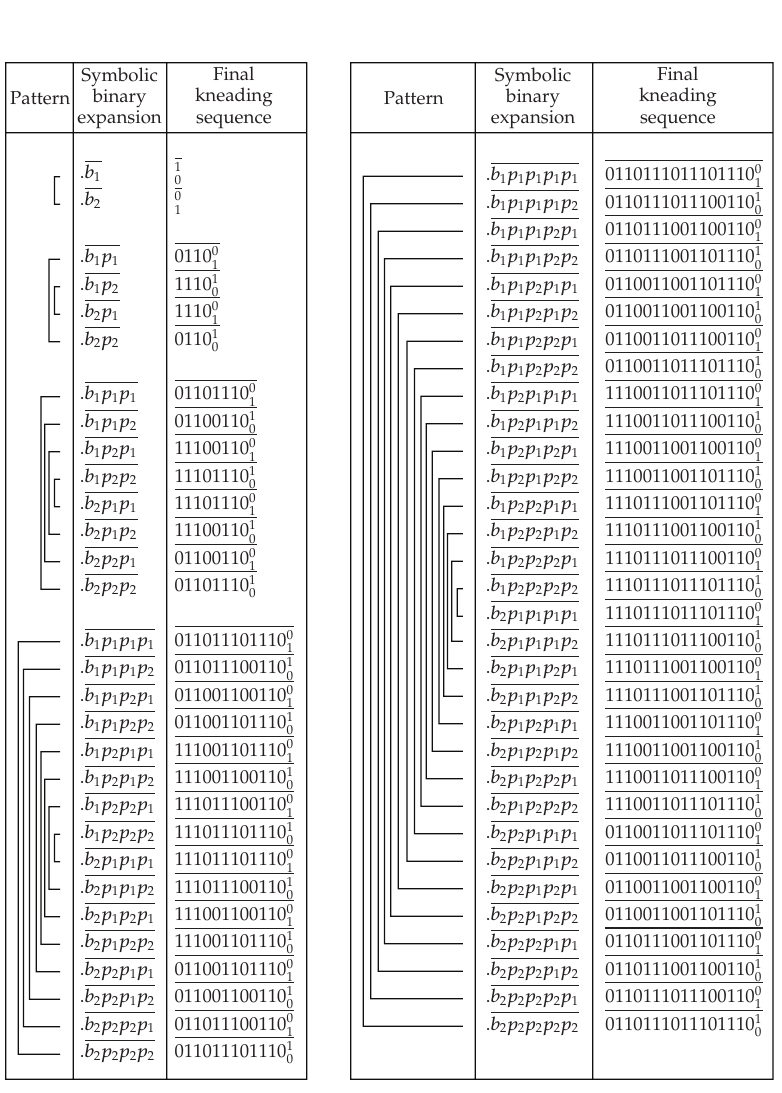
Figure 4: Coupling pattern of the external arguments of the BMSs up to fourth level in a canonical nonspiral medallion. The corresponding final kneading sequences are